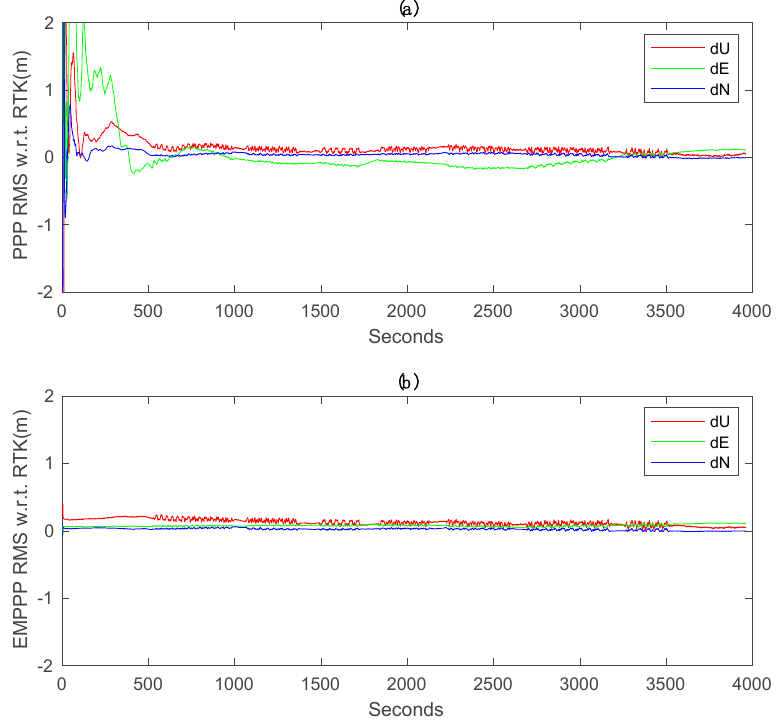
Figure 8. GPS-only kinematic positioning errors with respect to real-time kinematic (RTK): ( a ) traditional PPP errors, ( b ) EM-PPP positioning errors at the 500th iteration. Traditional PPP and EM-PPP share the same initial conditions.